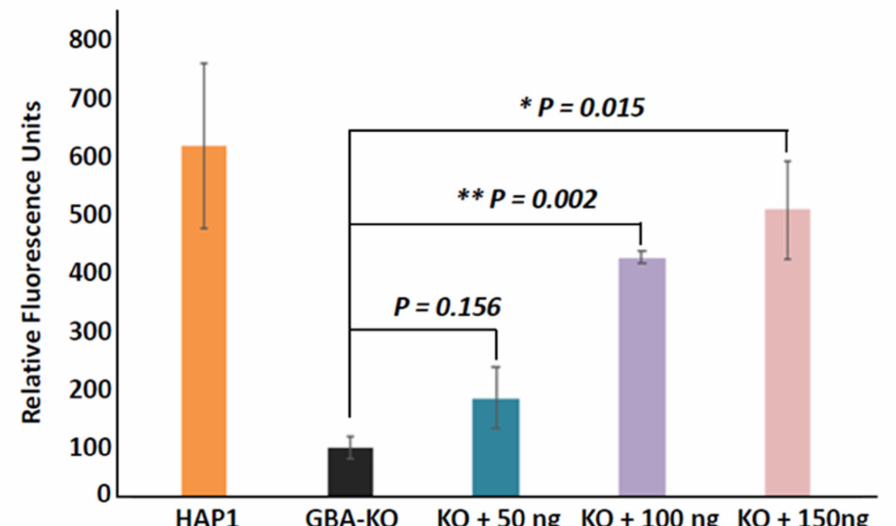
Figure 3. Effects of rhGBA replacement on the restoration of GBA activity in the GBA-KO cell model. The bar graph shows a significant decrease in GBA activity in the GBA-KO cells following rhGBA incubation as compared to the wild-type HAP1 cell. Treatment of GBA-KO cells with rhGBA for 24 h resulted in a dose-dependent restoration of GBA activity in GBA-KO lines. Data are mean ± standard deviation ( n = 3). * Denotes p < 0.05, while ** denotes p < 0.01, using Student’s t